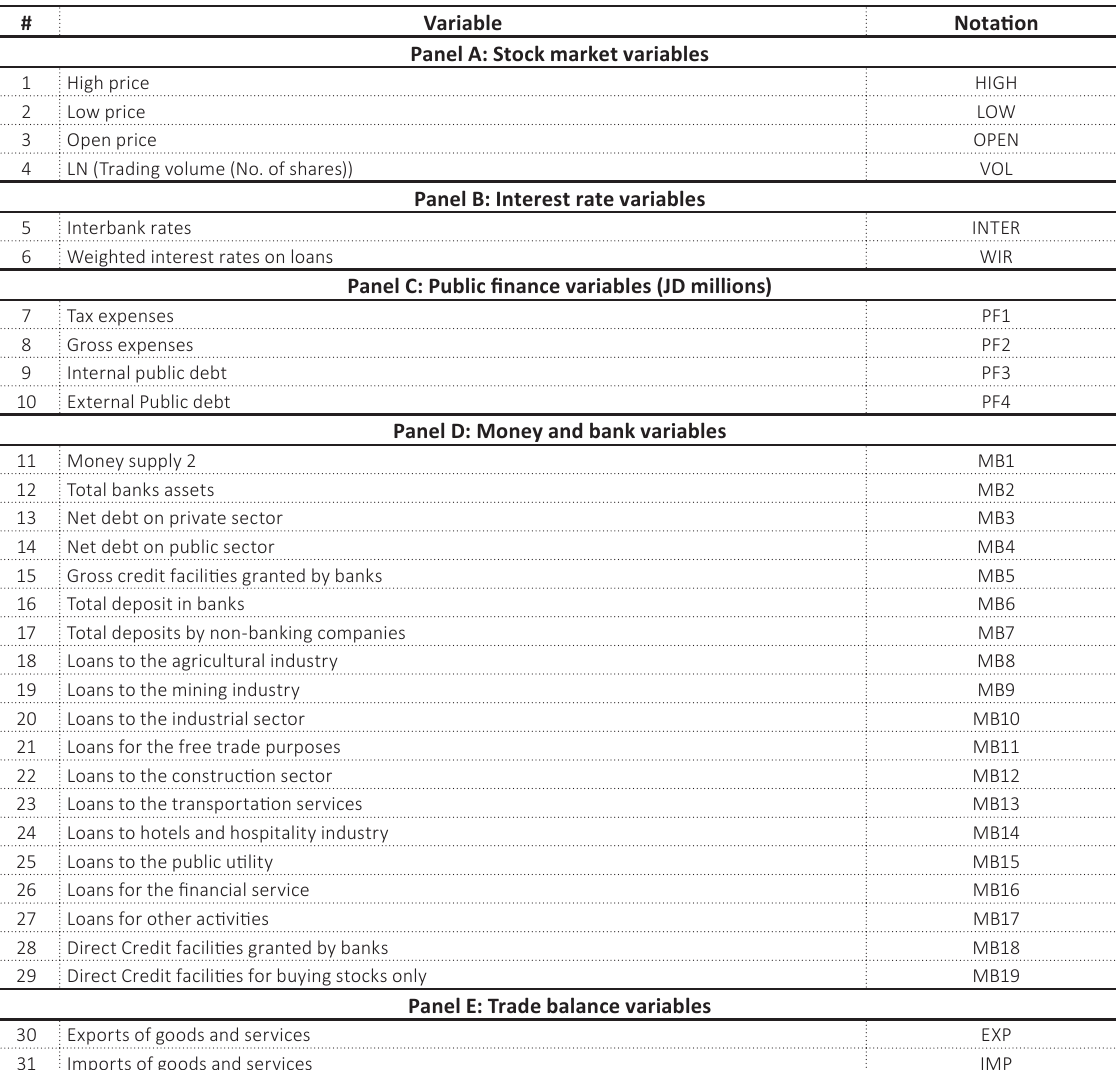
Table 1. List of predictors in the regressions and static